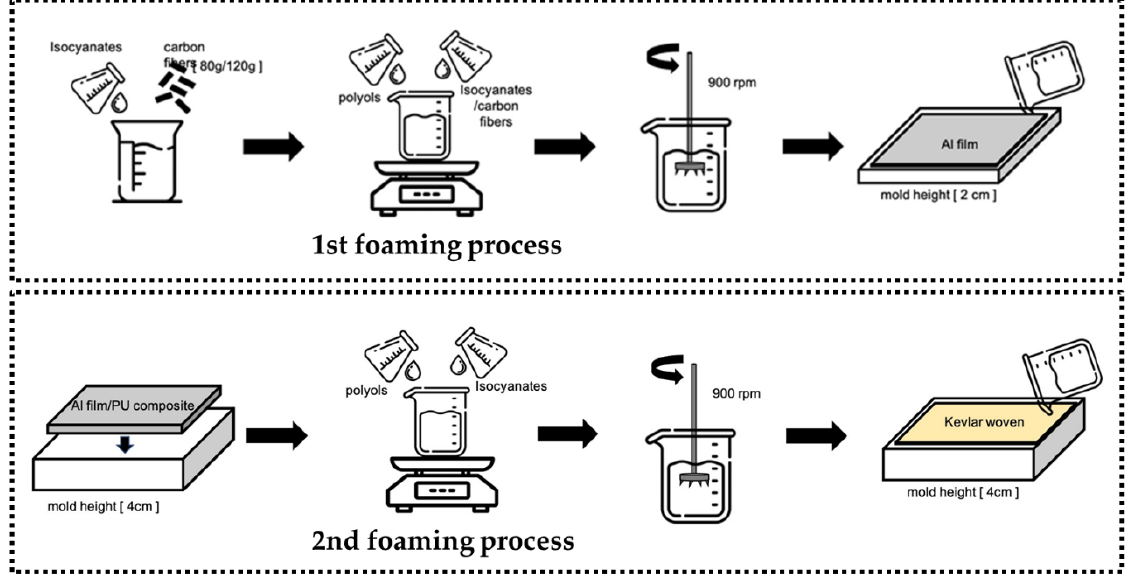
Figure 1. The preparation process of PU foam composites. Table 1. The specification of the PU foam composites.